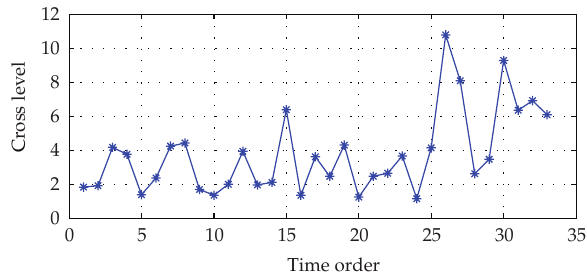
Figure 3: Changes of time series data at unit section.